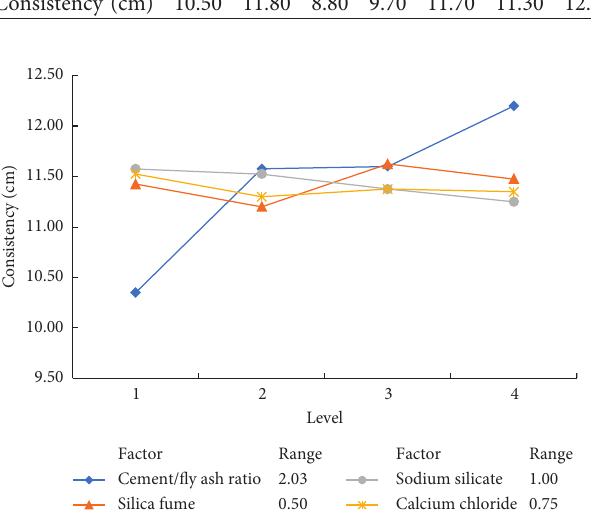
Table 3: Results of consistency testing for green fly ash-based grouting materials. Group